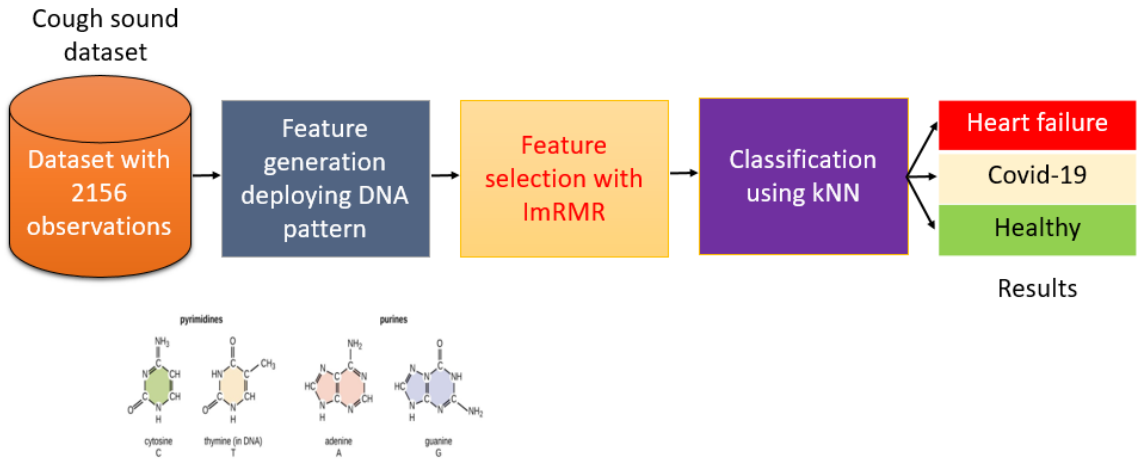
Figure 1. Illustration of proposed system for COVID-19 and HF detection using cough sounds. The pseudocode of the model is given in Algorithm 1.